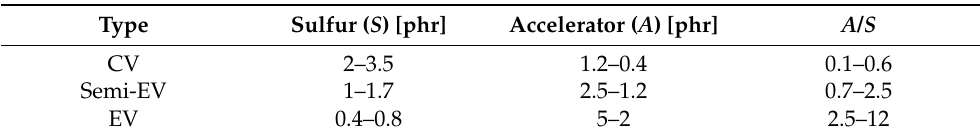
Table 2. Components used in conventional (CV), semi-efficient (semi-EV), and efficient (EV) vulcan- ization systems [2].